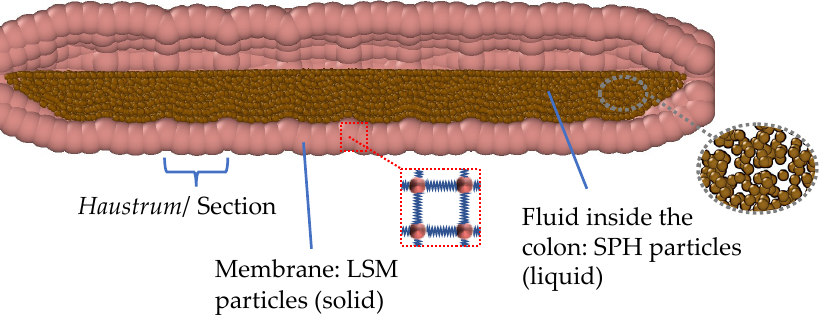
Figure 3. Particle representation of the model showing the colon haustra, the flexible membrane, and the fluid inside the colon.